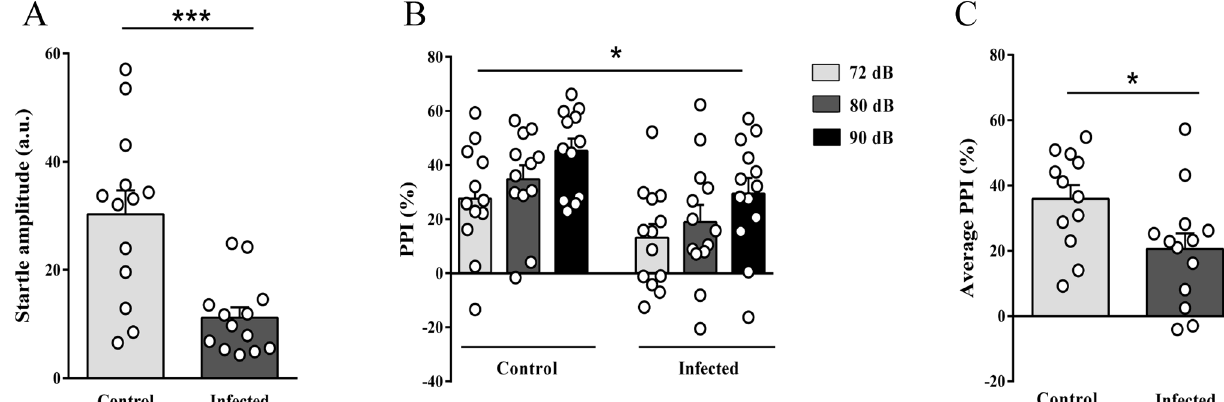
Figure 2. Deficit of startle reflex and prepulse inhibition in chronic T. gondii infection. Infected mice showed a significant decrease in startle amplitude ( A ) when 120 dB pulse was utilized without a prepulse. A reduction in %PPI ( B ) and %PPI average ( C ) were observed. Asterisks indicate statistically significant differences. * p < 0.05 and *** p < 0.001. Symbols correspond to individual subjects. dB = decibel. Control (n = 12), infected (n =